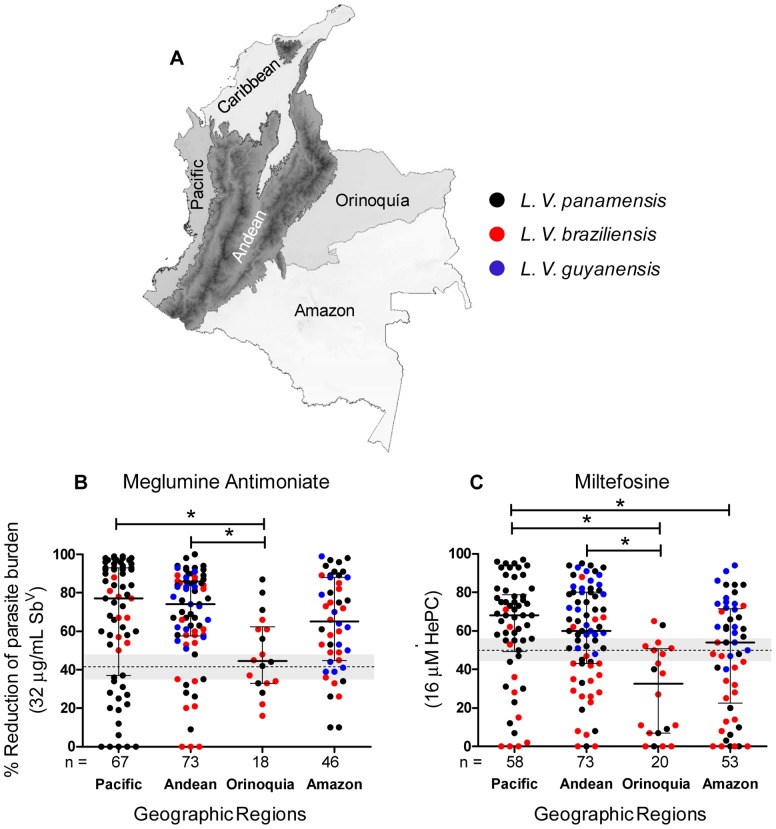
Susceptibility of Leishmania Viannia species from major natural geographic regions to meglumine antimoniate and miltefosine.Map of major natural geographic regions of Colombia (A). Susceptibility expressed as reduction of parasite burden at the discriminatory concentration of SbV (B) and HePC (C) in clinical strains of L. V. panamensis, L. V. braziliensis and L. V. guyanensis. Distributions of % reduction of parasite burden represent the median and the interquartile range. Qualitative classification of susceptibility is defined by the cutoff thresholds (dotted horizontal line) and indeterminate ranges are illustrated by gray shading. K-W for SbV: P = 0.012 and K-W for HePC: P<0.0001. * Dunn's multiple comparison test P<0.05.